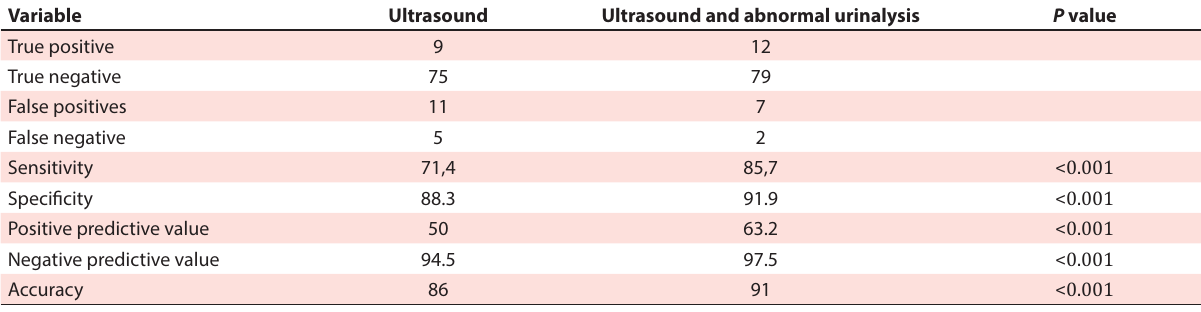
Table 2. Comparison of ultrasound statistical results by ultrasound with abnormal urine test Variable